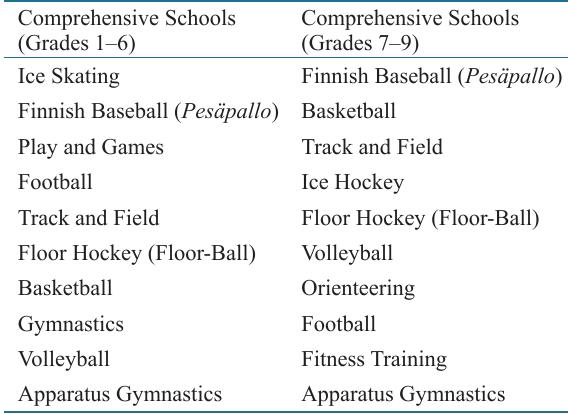
Most common activities in PE programs in